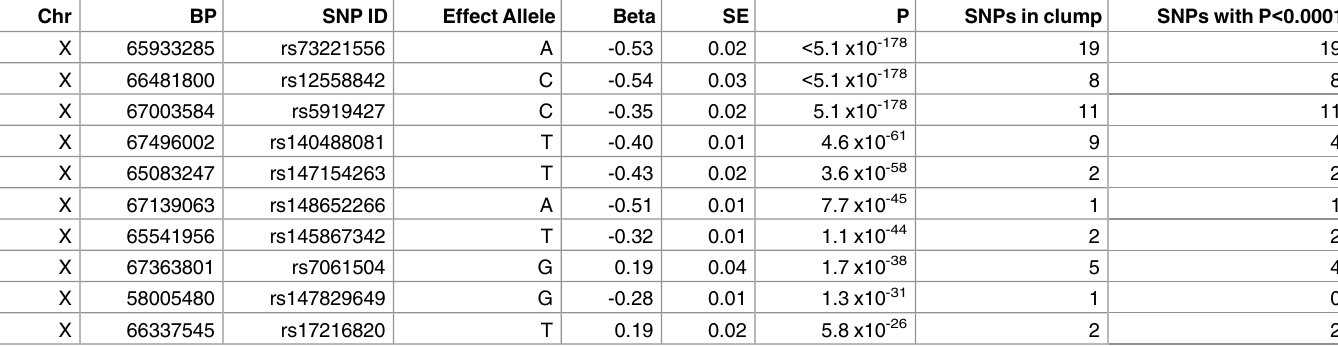
Table 2. List of top 10 genotyped male pattern baldness GWAS hits for the X chromosome.